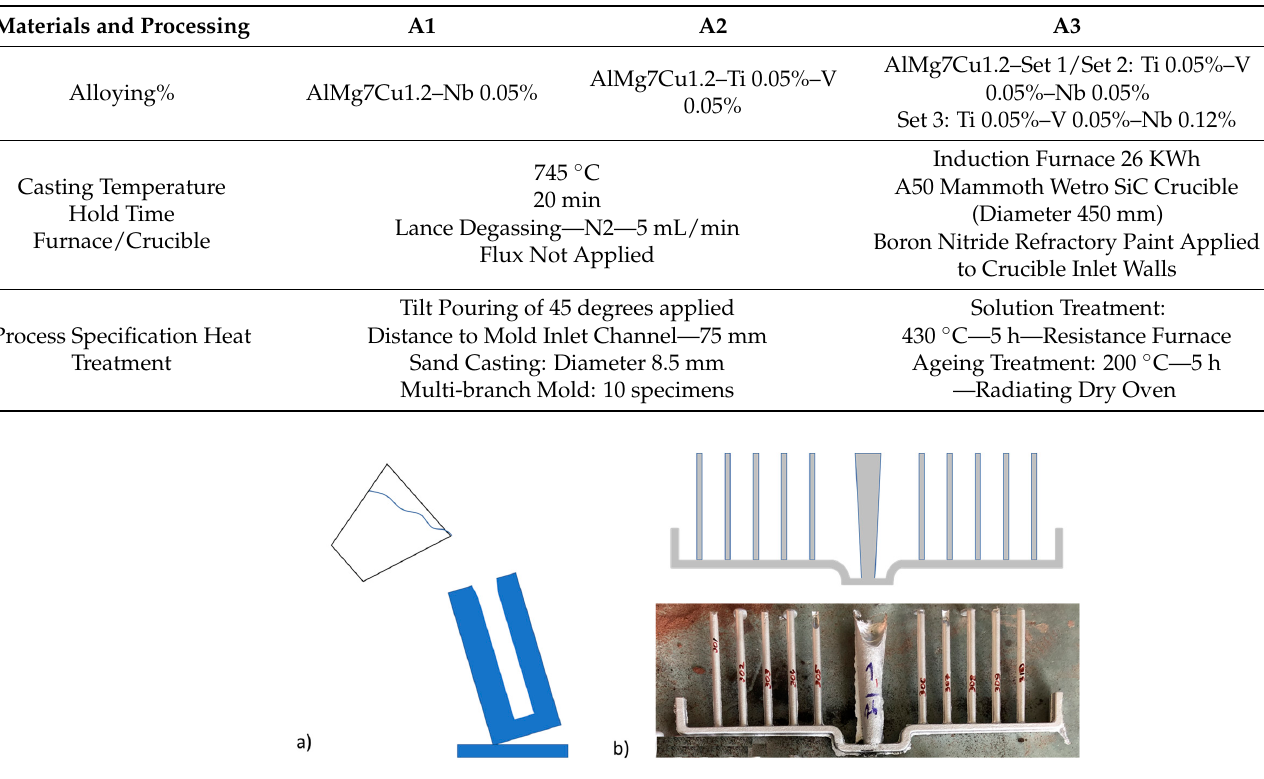
Figure 2. ( a ) Pouring Method and ( b ) 3D Mold Design/Fabricated Specimen Set.